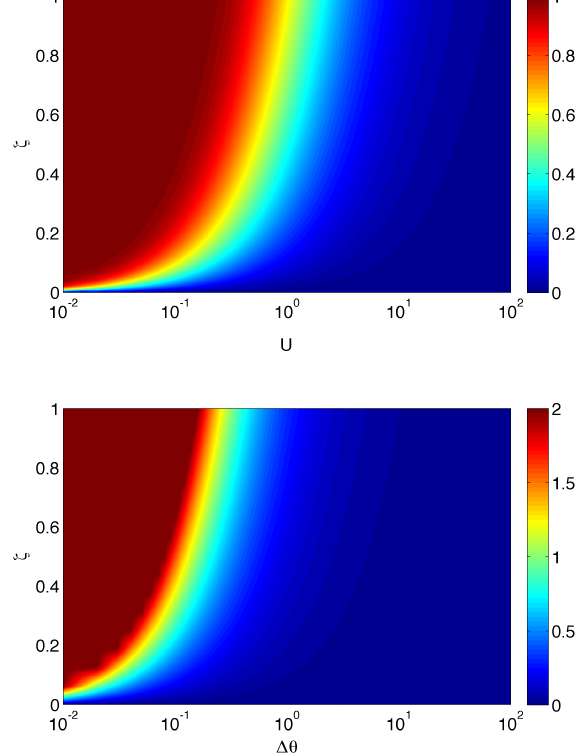
Fig. 2. Tidal current profile as a function of the Stokes number. Dis- tribution of normalised amplitude velocities (top), and phase differ- ence in pi radians